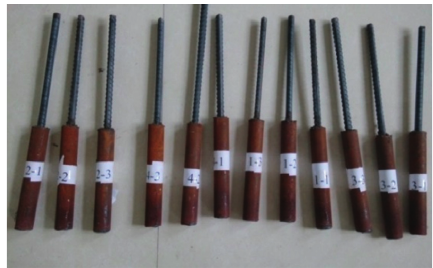
Figure 6: Process of making the pull-out